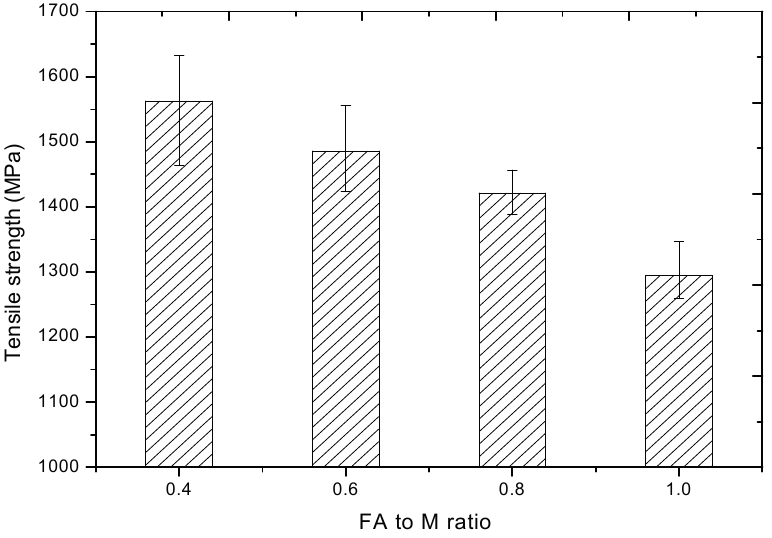
Figure 10. The tensile strength of MPC-based carbon FRIP